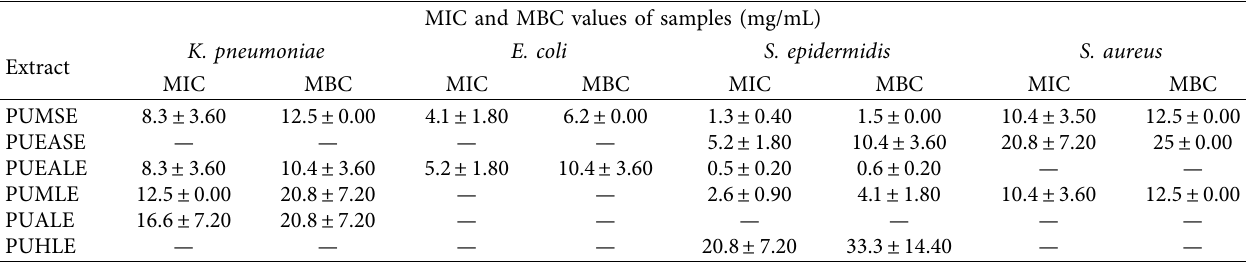
Table 7: Determination of MIC and MBC values of leaf and seed extract of P. utilis